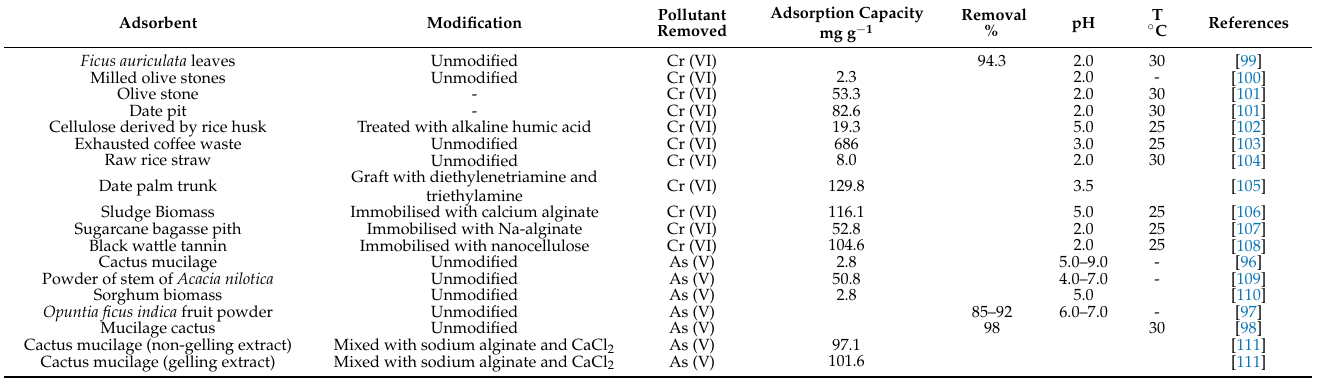
Table 5. The adsorption capacity of biosorbents that can remove anions Cr (VI) and As (V), and the conditions under which adsorption processes